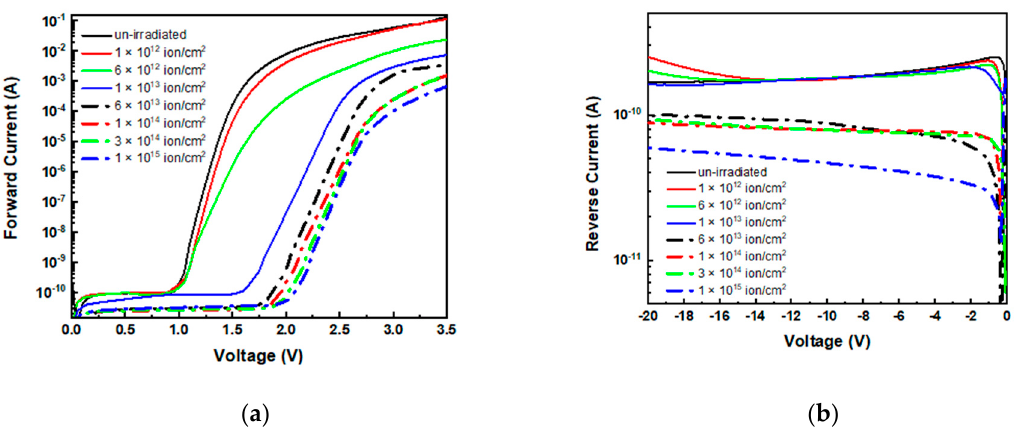
Figure 2. Forward ( a ) and reverse ( b ) current–voltage (I–V) characteristics of un-irradiated and 700 keV He + -irradiated devices at different fluencies.